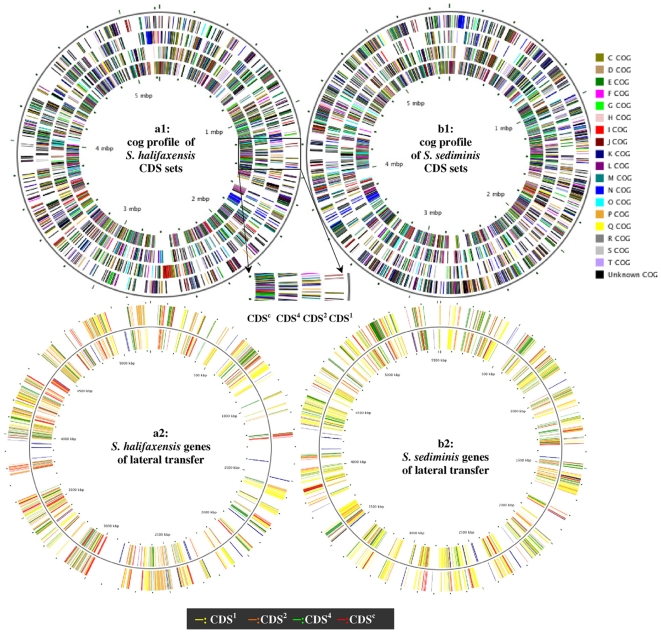
Circular maps of S.halifaxensis and S. sediminis genes in CDS subsets and laterally transferred.a1 or b1: cog profiles of CDS sets. CDSc, CDS4, CDS2 and CDS1 sets are explained in Table 2. One-letter abbreviations of cog are listed on the right side of b1. The corresponding color represent the following functional categories [69]: C, energy production and conversion; D, cell cycle control and mitosis; E, amino acid metabolism and transport; F, nucleotide metabolism and transport; G, carbohydrate metabolism and transport; H, coenzyme metabolism; I, lipid metabolism; J, translation; K, transcription; L, replication and repair; M, cell wall/membrane/envelope biogenesis; N, cell motility; O, post-translational modification, protein turnover, chaperone functions; P, inorganic ion transport and metabolism; Q, secondary metabolites biosynthesis, transport and catabolism; R, general functional prediction only; S, function unknown; T, signal transduction. a2,b2: Circular map of genes of lateral transfer. Red, green, brown or yellow color marks the genes in CDSc, CDS4, CDS2, or CDS1, respectively.